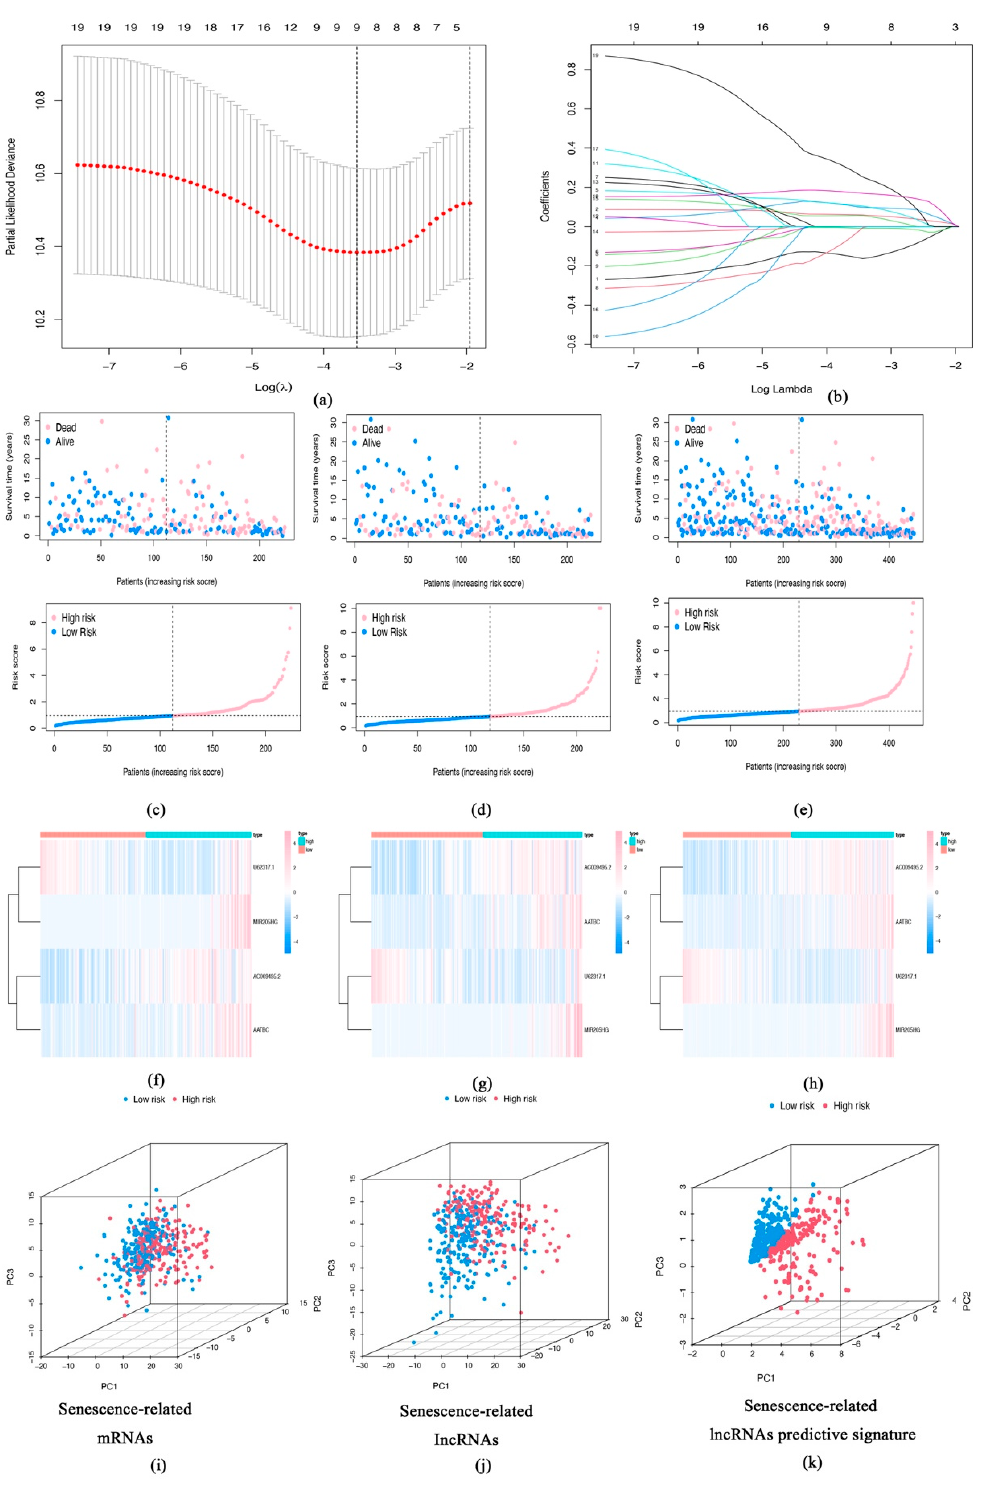
Figure 3. Construction of senescence-related lncRNA signature and evaluation of predictive effects. ( a , b ) Lasso regression analysis. ( c – e ) With increasing risk scores from left to right, the distribution of survival states was shown by the scatter plots in the training cohort ( c ), test cohort ( d ), and entire cohort ( e ). ( f – h ) The four senescence-related lncRNAs expression heatmap in training cohort ( f ), test cohort ( g ), and entire cohort ( h ). ( i – k ) Clustering visualization of patients in different risk groups was performed using principal component analysis (PCA). The blue plots represent low risk and the red plots represent high risk groups.